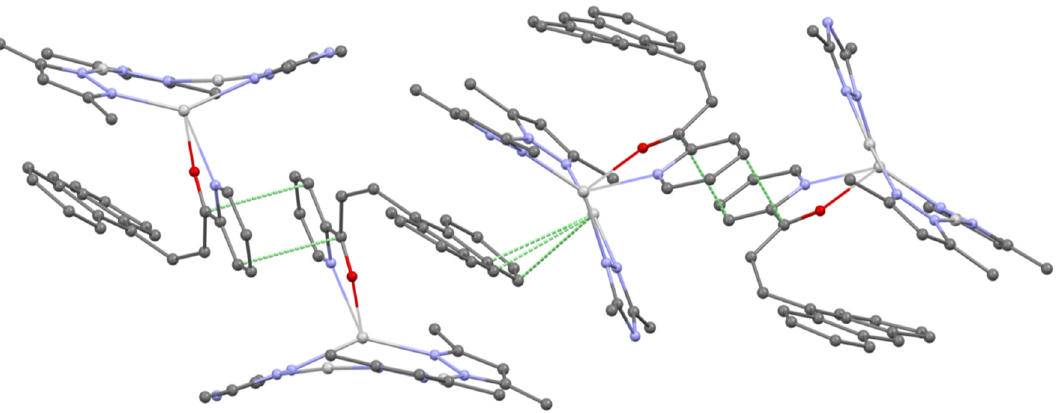
Figure 4. Fragment of a supramolecular packing of complex Z -1Ag demonstrating Ag- π antra (3.317–